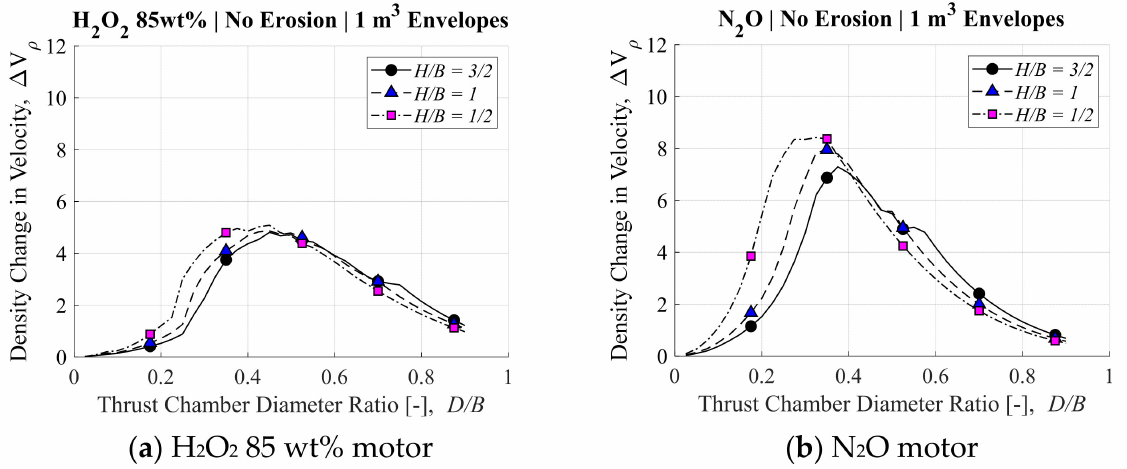
Figure 15. Realistic ∆ V ρ solutions spaces for all three envelopes without nozzle throat